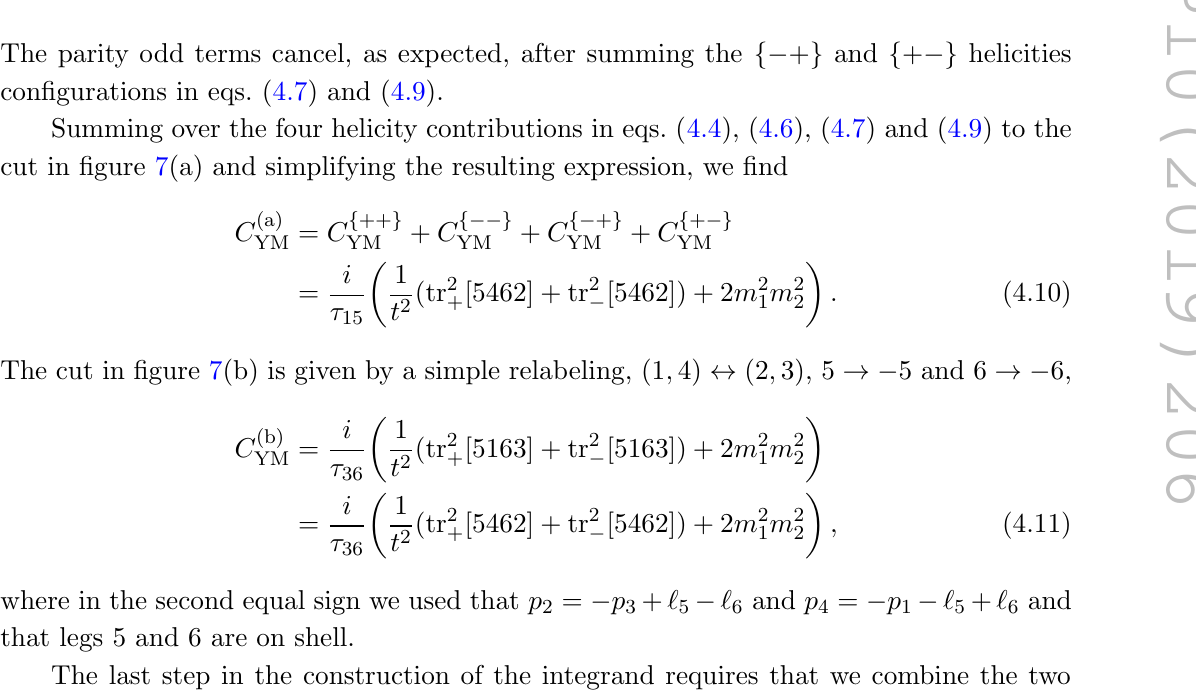
Figure 9 . The one-loop box and triangle integrals. The top and bottom thick lines are massive scalars 1 and 2, respectively, and the thin lines are